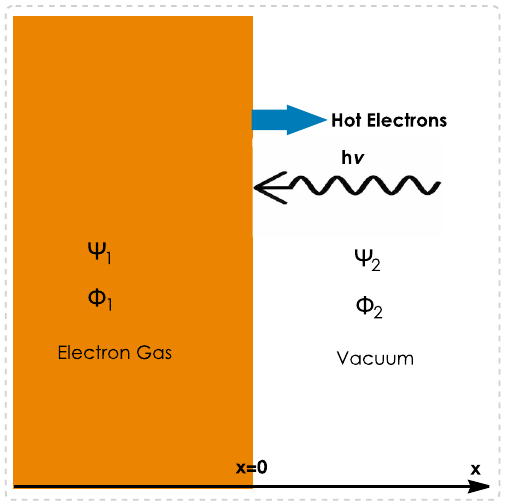
Figure 4. The schematic of collective hot-electron release at the irradiated metal–vacuum interface leading to the energetic photo-plasmonic effect. The wavefunction �( x ) and electrostatic energy �( x ) characterize the quantum state at each